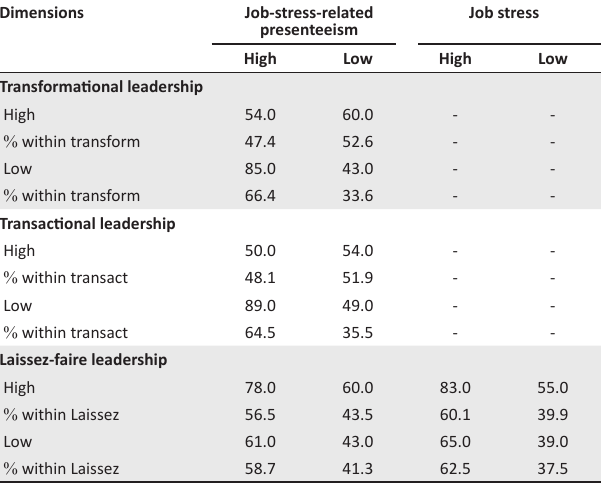
TABLE 6: Cross-tabulation table.